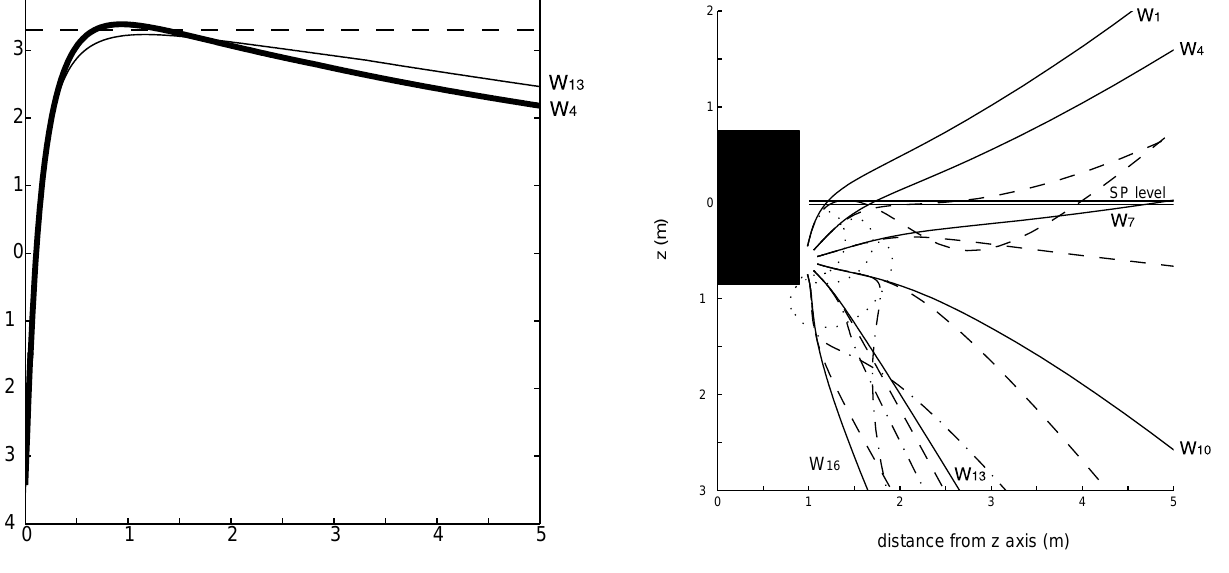
Fig. 3. Curves of the potential versus distance along the directions of windows w 4 (thick curve) and w 13 (thin curve).